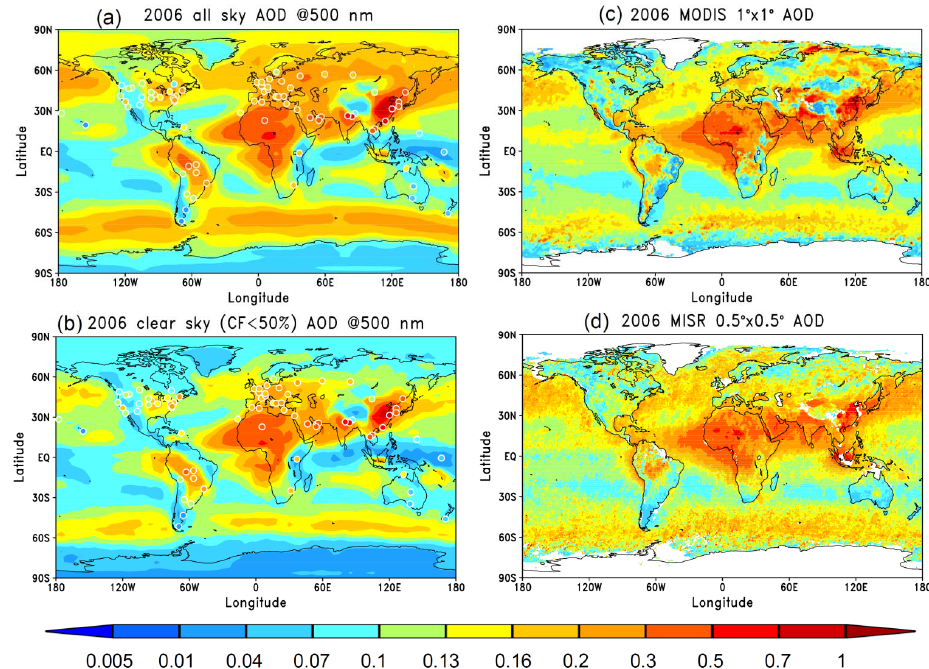
Fig. 6. Modeled annual mean total AOD at 500nm for all sky and clear sky (grid box overall CF < 0.5) with the observations (at 500nm) from AERONET overlapped on modeled values, as well as values from MODIS (at 550nm) and MISR (at 555nm) for 2006. Only the Level 2.0 AEORNET data (cloud-screened and quality-assured) at 500nm with at least 9 months of available data in 2006 (total 77 sites) are included in the comparison. MODIS (Moderate Resolution Imaging Spectroradiometer) AOD data is based on the monthly level-3 product from Aqua (MYD08 M3.051) with 1 × 1 ◦ degree resolution, and combined with deep blue product, which is the separate product specifically retrieved for the AOD over desert regions. MISR (Multi-angle Imaging SpectroRadiaometer) aerosol AOD data used here is the annual mean of monthly level-3 product with a resolution of 0 . 5 × 0 . 5 ◦ .